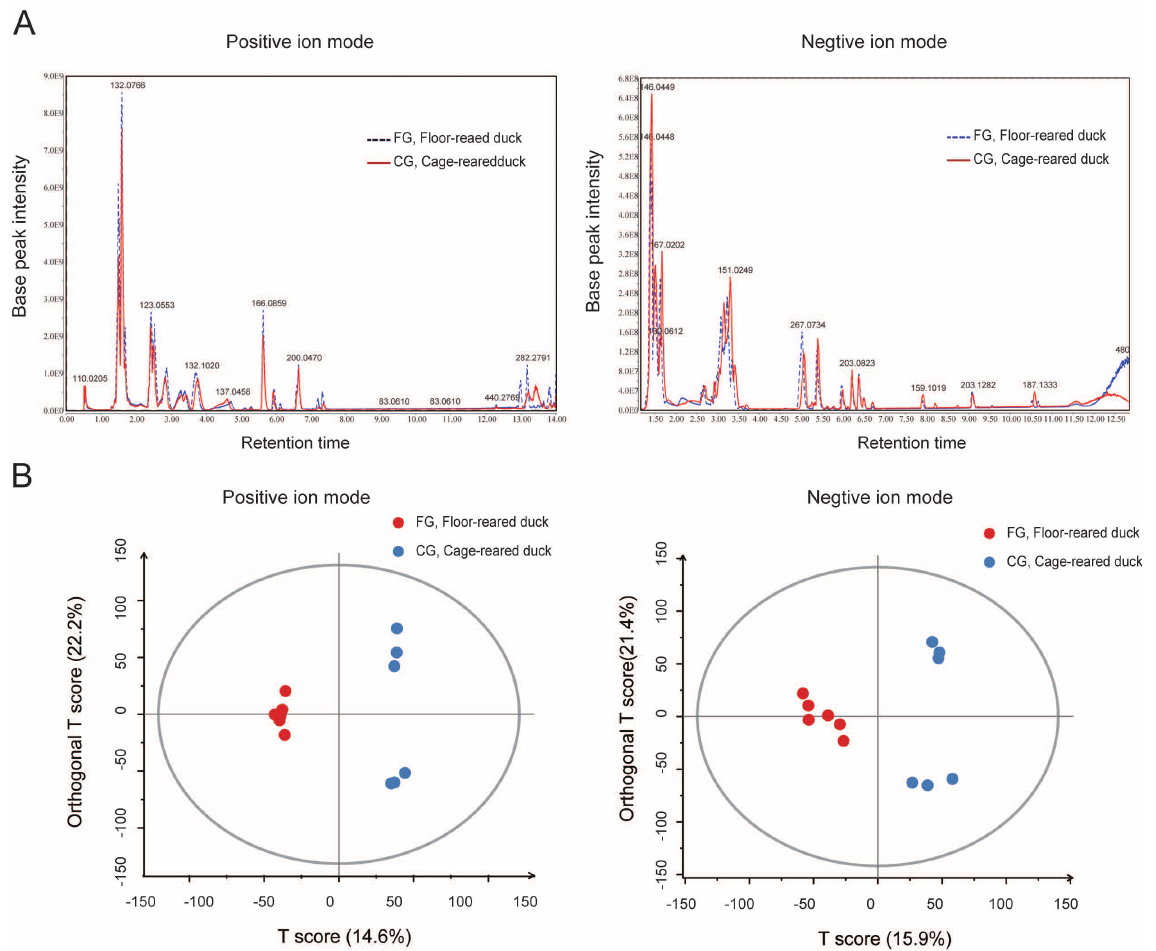
Figure 2. Separation of metabolic components of duck uropygial glands under different rearing systems. ( A ): The base peak chromatogram (BPC) of positive ion and negative ion modes. The BPC was generated with ion strength as the ordinate and time as the abscissa. The components separated by chromatography continuously enter the mass spectrometer, and the mass spectrometer constantly scans for data. Each scan obtains a mass spectrum. The strongest ion in each mass spectrum is selected for the continuous description. ( B ): OPLS-DA score of the metabolic components of duck uropygial glands for both positive and negative ion modes. FG, floor-reared duck; CG, cage-reared duck.